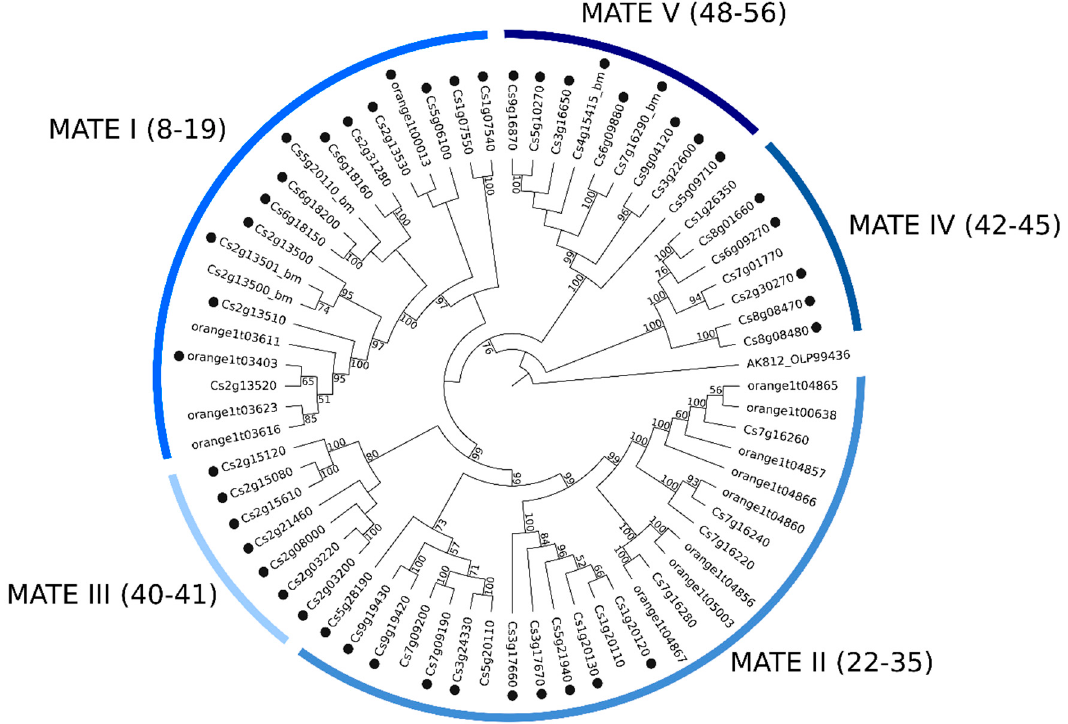
Figure 3. Maximum likelihood tree of 67 MATE amino acid sequences from C. sinensis genome. Numbers above the branches represent bootstrap values. The black circles represent genes that have an associated transcript sequence in the citrus reference transcriptome (CRT). AK812_OLP99436 was used as outgroup ( Symbiodinium microadriaticum str. CCMP2467, Gene: slc47a1, multidrug, and toxin extrusion protein 1).